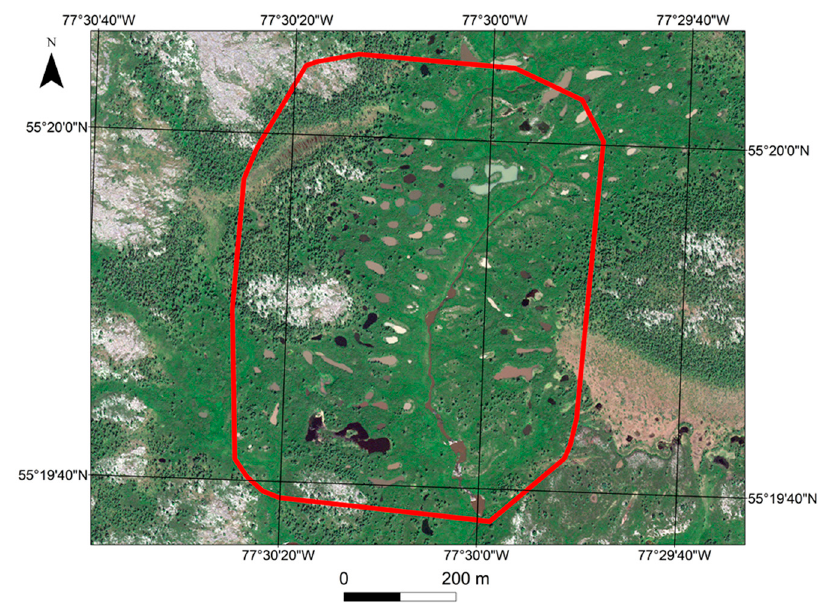
Figure 2. Detailed KWAK study area with the boundary of the Unmanned Aerial System survey shown in red (true color composite from WorldView-4 – © 2018 DigitalGlobe, Inc., Longmont CO USA